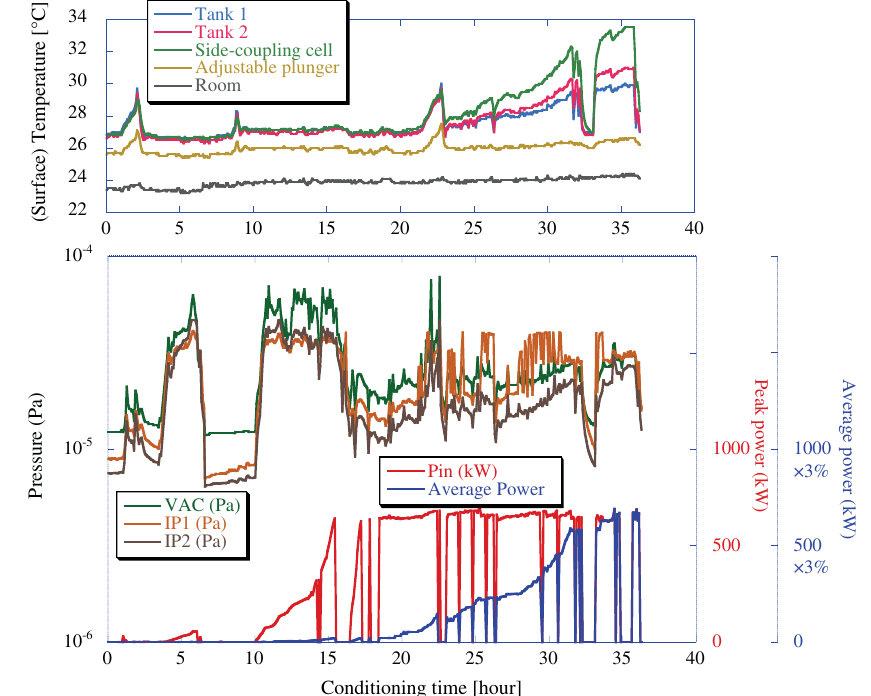
FIG. 12. Temperature (top) and conditioning (bottom) history of the ACS buncher module. The temperature rises were monitored by is the input power, as shown in Fig. 10. This graph shows the data points per five minutes. Thus, a resistance thermometers (Pt100). P in short downtime does not appear in this graph. The pressure denoted by VAC is the pressure at the center of the bridge cavity, while those denoted by IP1 and IP2 are the pressures monitored by the currents in the two ion pumps.